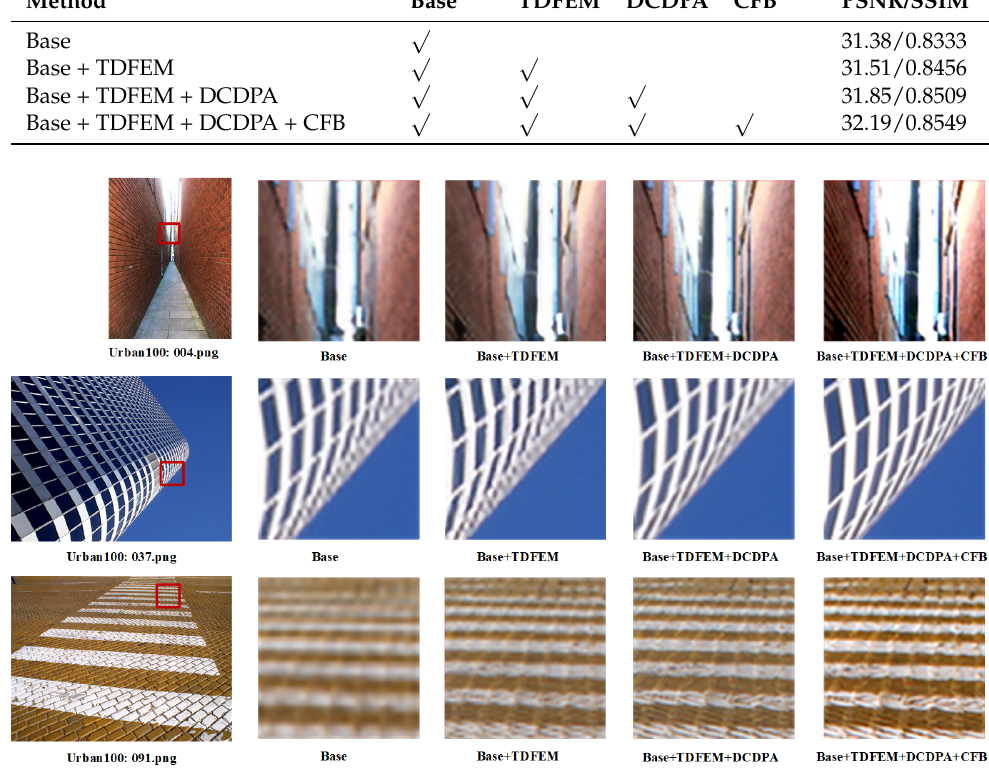
Figure 8. Comparison of ablation experiment